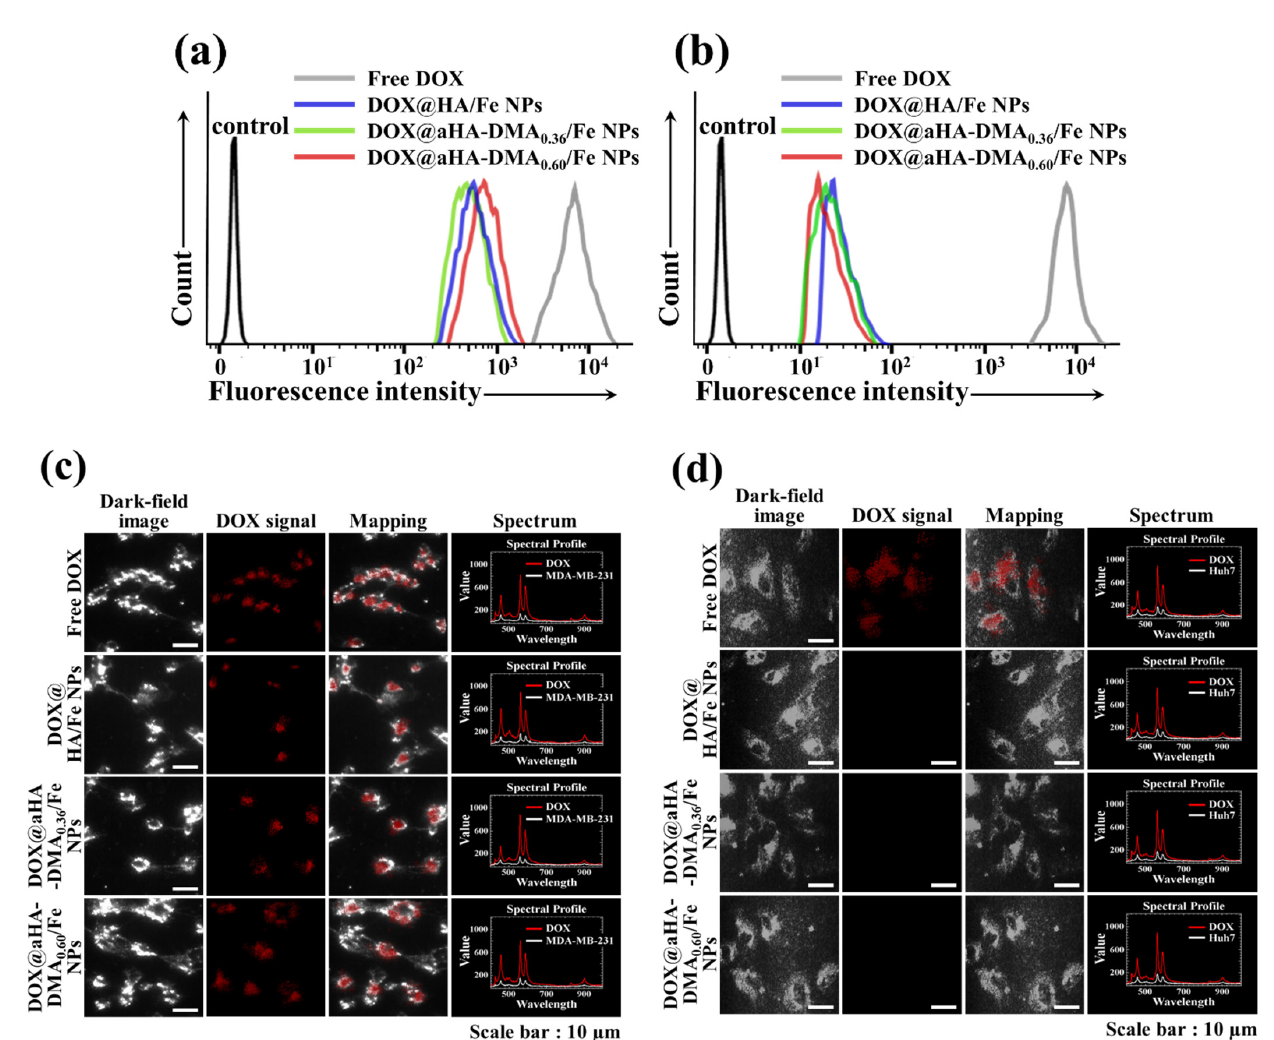
Figure 3. Flow cytometry analysis of ( a ) MDA-MB-231 cells and ( b ) Huh7 cells treated with free DOX (10 μ g/mL) or NPs (equivalent to DOX 10 μ g/mL) for 4 h of incubation at 37 °C. Here, control refers to cells that were not treated with drugs. Hyperspectral images of ( c ) MDA-MB-231 cells and ( d ) Huh7 cells treated with free DOX (10 μ g/mL) or NPs (equivalent to DOX 10 μ g/mL) for 4 h incubation at 37 °C.